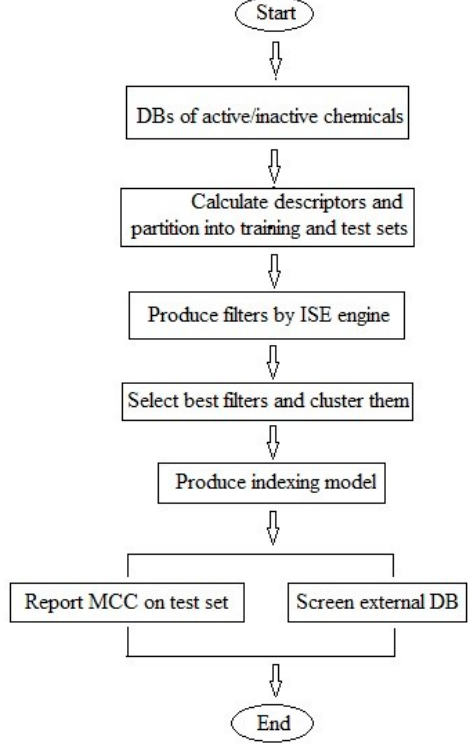
Figure 2. Flowchart for the ligand-based modeling process. ISE, iterative stochastic elimination; MCC, Matthews correlation coefficient.